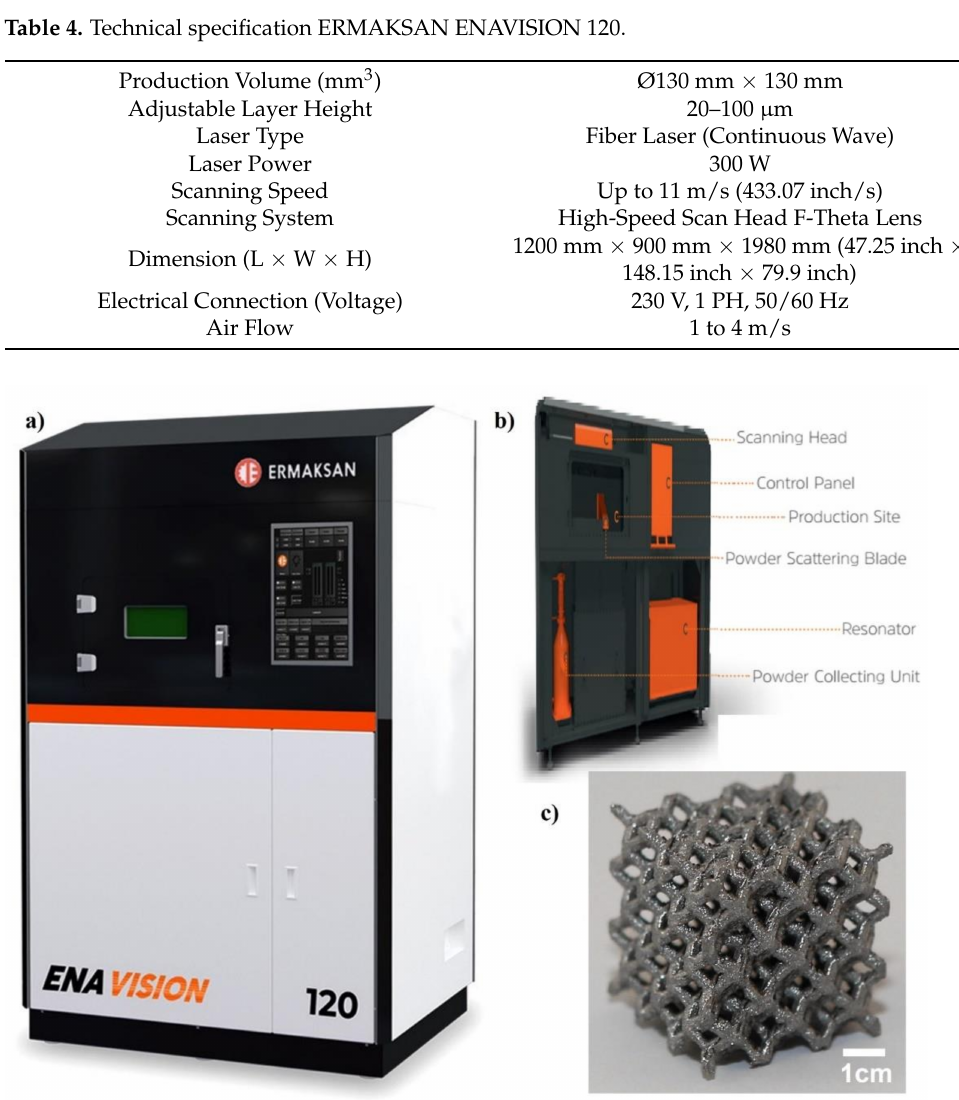
Figure 4. ( a ) ENAVISION 120 used for validation, ( b ) machine breakdown, and ( c ) manu- factured